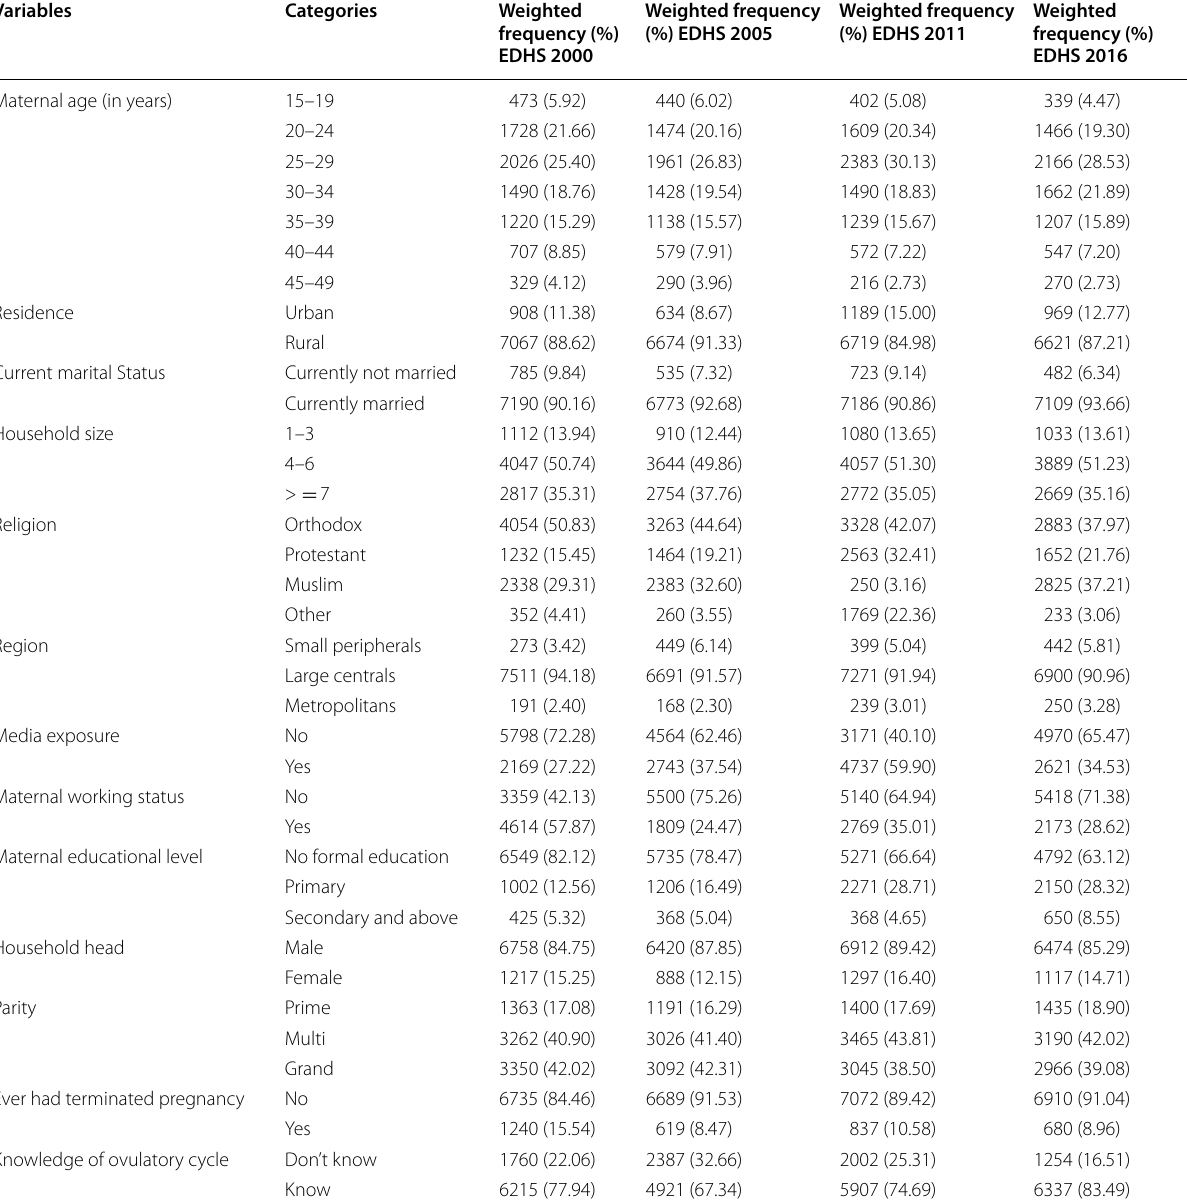
Table 1 The characteristics of the study participants of 2000, 2005, 2011, and 2016 Ethiopian Demographic and Health survey